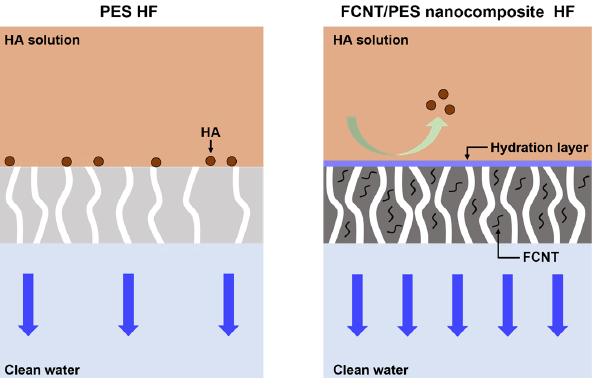
Figure 8. Schematic illustration of filtration and antifouling mechanisms of PES and FCNT/PES nanocomposite HF membranes.